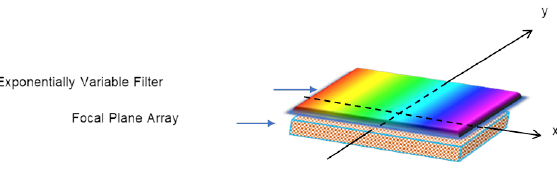
Figure 1. The EVF unit mounted on the detector plane of the miniature hyperspectral imager